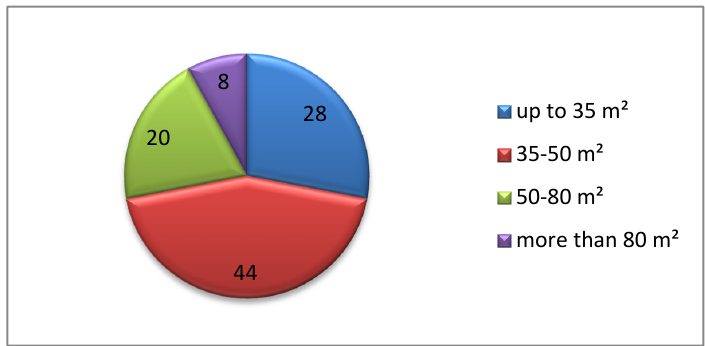
Figure 7. Apartment square footage at a senior housing estate preferred by the respondents.